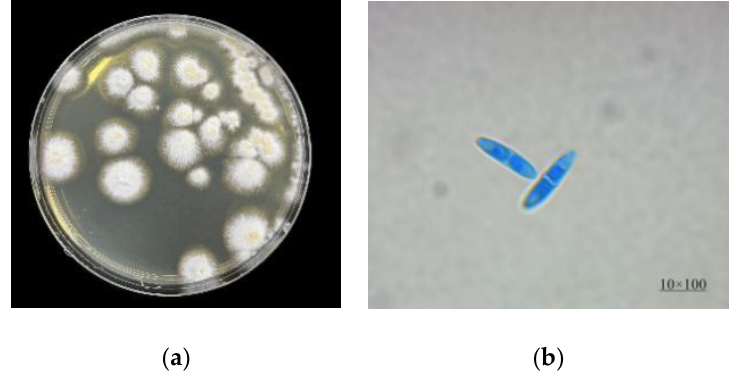
Figure 1. Colony ( a ) and microscopic ( b ) morphology of strain